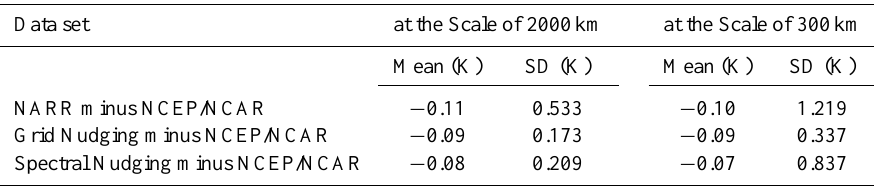
Subscripts s, 850 and 500 stand for surface, 850hpa and 500hpa. Table 2. Summary of the Mean and Standard Deviation (SD) of the Distribution of Temperature. Difference at 500hpa of July 2009 at Different Scales.